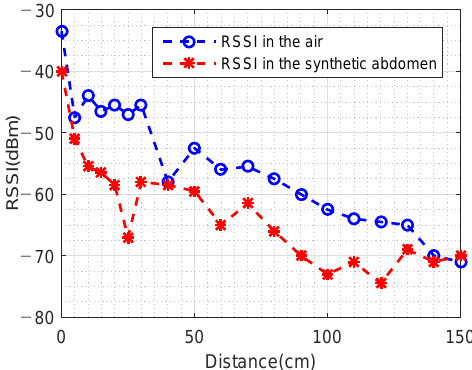
Figure 13. RSSIs with respect to stator-rotor distances.